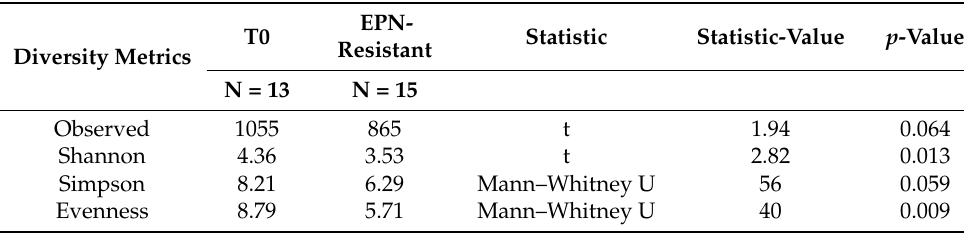
Table 2. Comparison of diversity metrics between the T0 group of A. solstitiale larvae and EPN- resistant larvae.